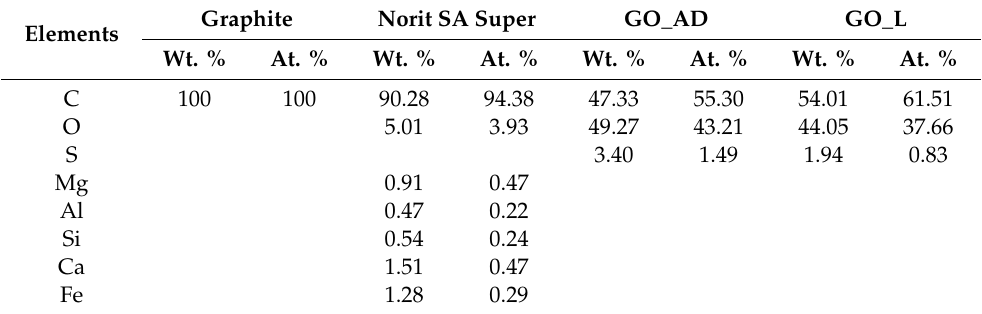
Table 1. Energy dispersive spectroscopy (EDS) elemental analysis of carbon materials investigated. Graphite Norit SA Super GO_AD GO_L Elements Wt. % At. % Wt. % At.